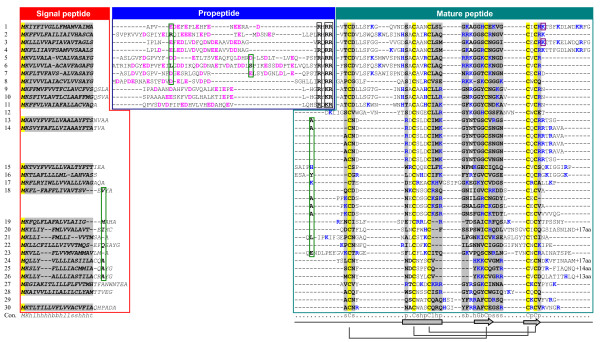
Multiple sequence alignment of navidefensins, nasonins and related peptides. 1: Amdefensin1(Am); 2: Amdefensin2(Am); 3: Navidefensin1-1(Nv); 4: Navidefensin1-2(Nv); 5: Navidefensin2-1(Nv); 6: Navidefensin2-2(Nv); 7: Navidefensin2-3(Nv); 8: Navidefensin3(Nv); 9: Phormicin(Pt); 10: Sapecin(Sp); 11: Dmdefensin(Dm); 12: Heliomicin(Hv); 13: Nasonin-1(Nv); 14: Nasonin-2(Nv); 15: Nasonin-3(Nv); 16: Nasonin-4(Nv); 17: Nasonin-5(Nv); 18: Nasonin-6(Nv); 19: Nasonin-7(Nv); 20: Nasonin-8(Nv); 21: Nasonin-9(Nv); 22: Nasonin-10(Nv); 23: Nasonin-11(Nv); 24: Nasonin-12(Nv); 25: Nasonin-13(Nv); 26: Nasonin-14(Nv); 27: Cobatoxin-1(Cn); 28: Cll-Defensin1(Cll); 29: Ps-Termicin(Ps); 30: Dr-Termicin(Dr). Am: A. mellifera, Nv: N. vitripennis, Pt: Protophormia terraenovae, Sp: Sarcophaga peregrine, Dm: D. melonagaster, Hv: Heliothis virescens, Cn: Centruroides noxius, Cll: C. limpidus limpidus, Ps: Pseudacanthotermes spiniger, Dr: Drepanotermes rubriceps. Secondary structure elements (α-helix: cylinder; β-strand: arrow) and disulfide bridge connectivity are shown on the bottom of the alignment. Acidic residues in the propeptide are shown in pink and cleavage sites are boxed. Identical amino acids or constitutive replacements are shadowed in yellow and grey, respectively. Consensu/60% (Con.): - (negative), * (Ser/Thr), l (aliphatic), + (positive), t (tiny), a (aromatic), c (charged), s (small), p (polar), b (big), h (hydrophobic). Basic residues (K, R, H) are shown in blue. Residues split by phase 1 or 2 introns are boxed in green or purple. Omitted residues in carboxyl-termini are indicated by +aa.